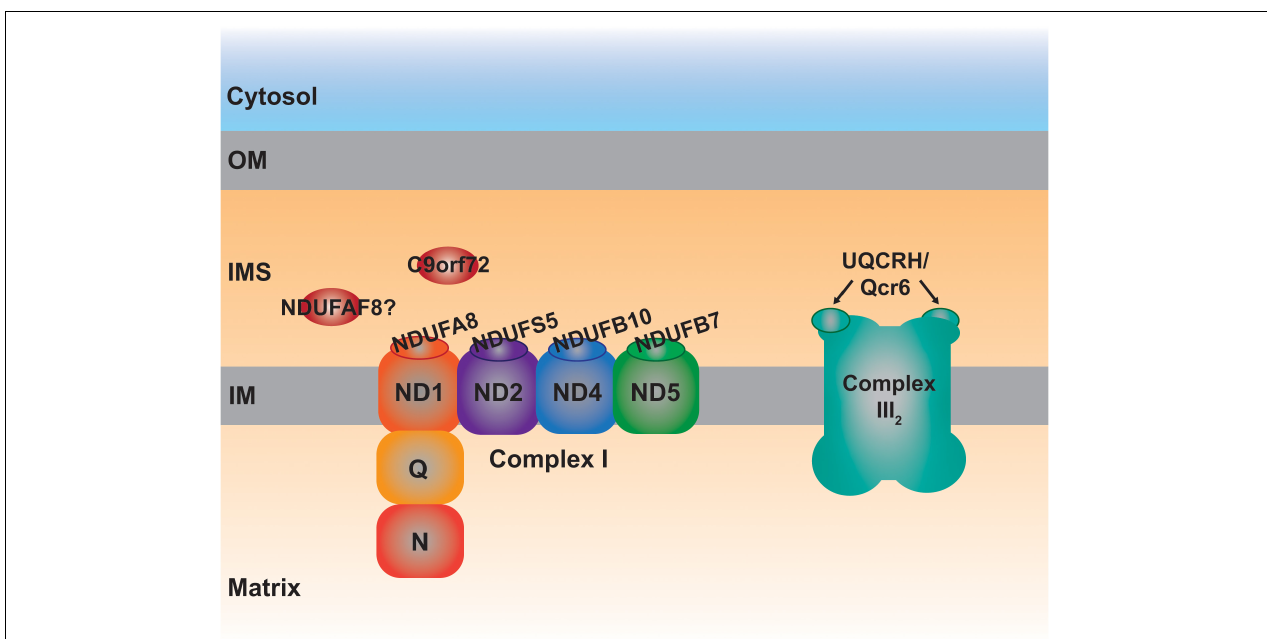
FIGURE 3 | Schematic representation of the MIA40 protein substrates located in the IMS involved in the assembly of complexes I and III 2 . Each one of the IMS CI structural subunits, NDUFA8, NDUFS5, NDUFB10, and NDUFB7 belongs to a different module (ND1, ND2, ND4, and ND5, respectively) of the membrane arm, responsible for proton pumping. The peripheral arm of CI is composed of the quinone binding (Q) and NADH dehydrogenase (N) functional modules. UQCRH, Qcr6 in yeast, is an IMS-located supernumerary